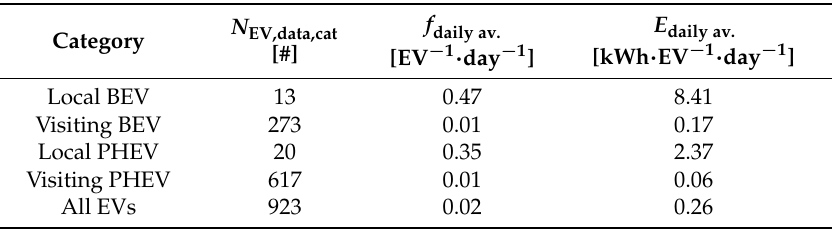
Table 1. Key figures of electric vehicle (EV) charging station measured data analysis over the measurement period 1 August 2017 to 31 July 2018, covering 21 charging stations within the Lombok district in the city of